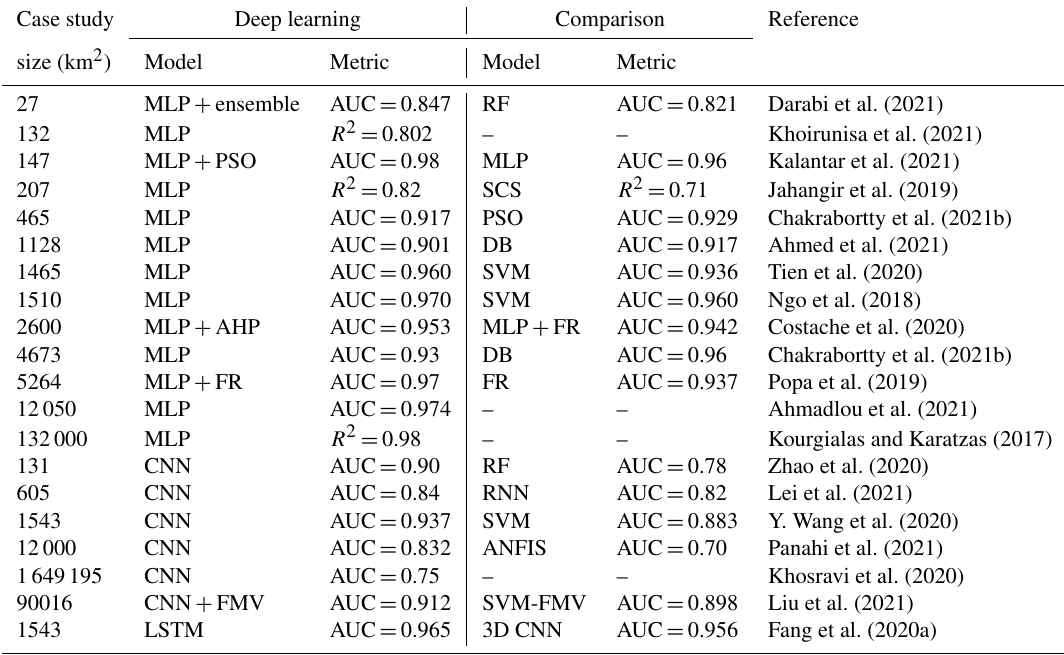
PSO is the particle swarm optimization, SCS is the soil conservation system model, SVM is the support vector machine, AHP is the analytic hierarchy process, RF is the random forest, FR is the frequency ratio, DB is the deep boost, ANFIS is the adaptive neuro-fuzzy inference system, and FMV is the fuzzy membership